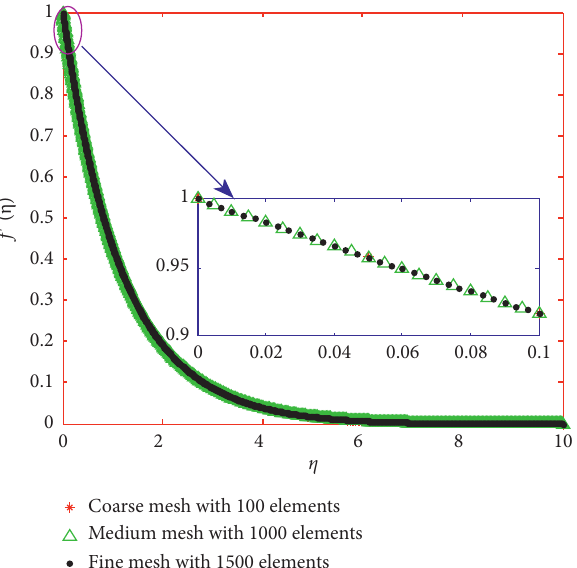
Figure 26: Grid-independence test showing every fifth element of the mesh for velocity profile.